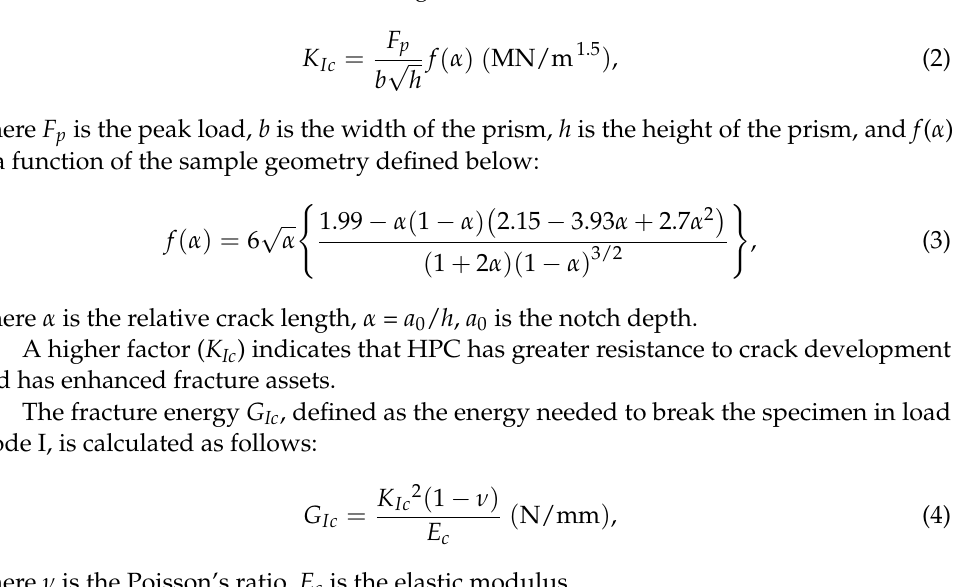
Figure 7. Exemplary test dependences of HPC load-deflection for CSF content of ( a ) 0%; ( b ) 5%; ( c ) 20%; ( d )